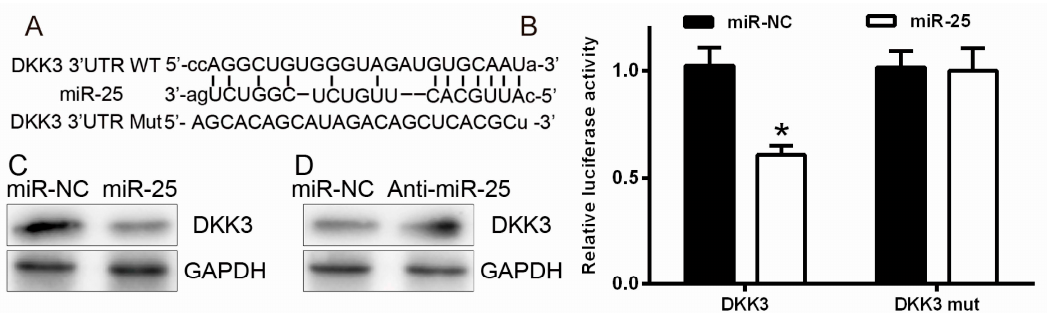
Figure 3. Prediction and identification of the miR-25 target. ( A ) Diagram for construction of the miR-25 binding site in the pGL3 vector. Mutation analysis of the miR-25 binding site; ( B ) identification of the miR-25 target gene. HEK293 cells were co-transfected with miR-NC, miR-25, and DKK3-pGL3 for the dual-luciferase assay. Renilla luciferase was expressed in pRL-TK vector, and was co-transfected with 3 ′ -UTR of DKK3 for normalization; ( C , D ) DKK3 protein levels in miR-25 or anti-miR-25-treated HEK293 cells were measured by Western blot analysis. GAPDH used as an internal standard. * p < 0.05.